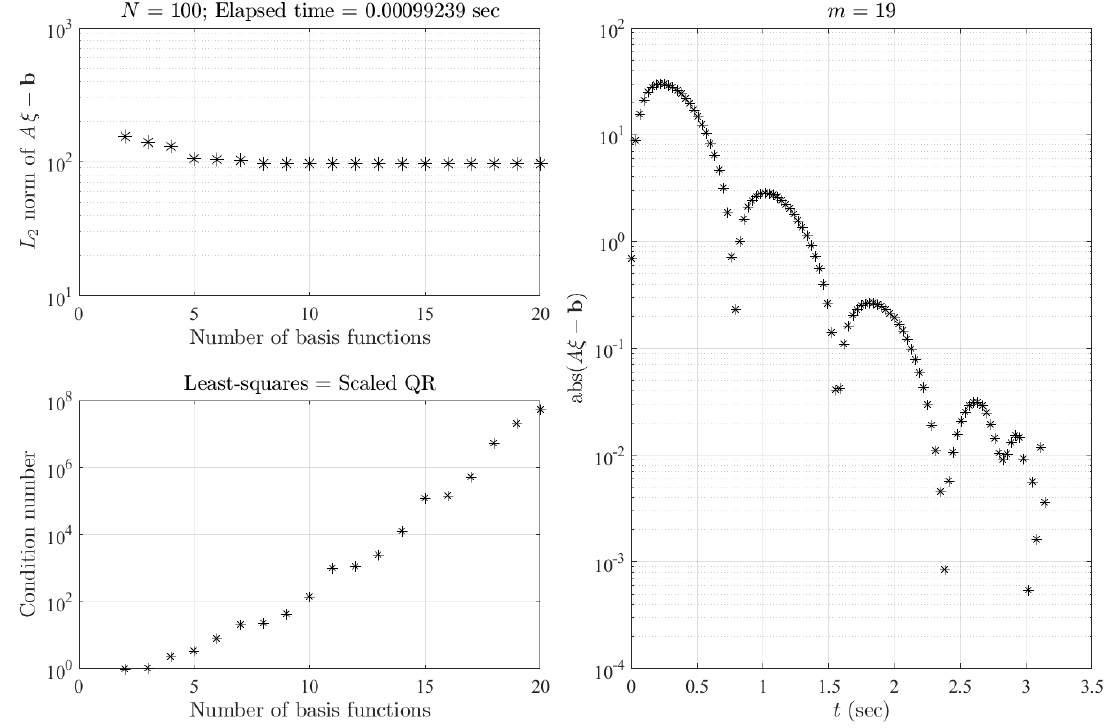
Figure 4. Least-squares-approach results (no